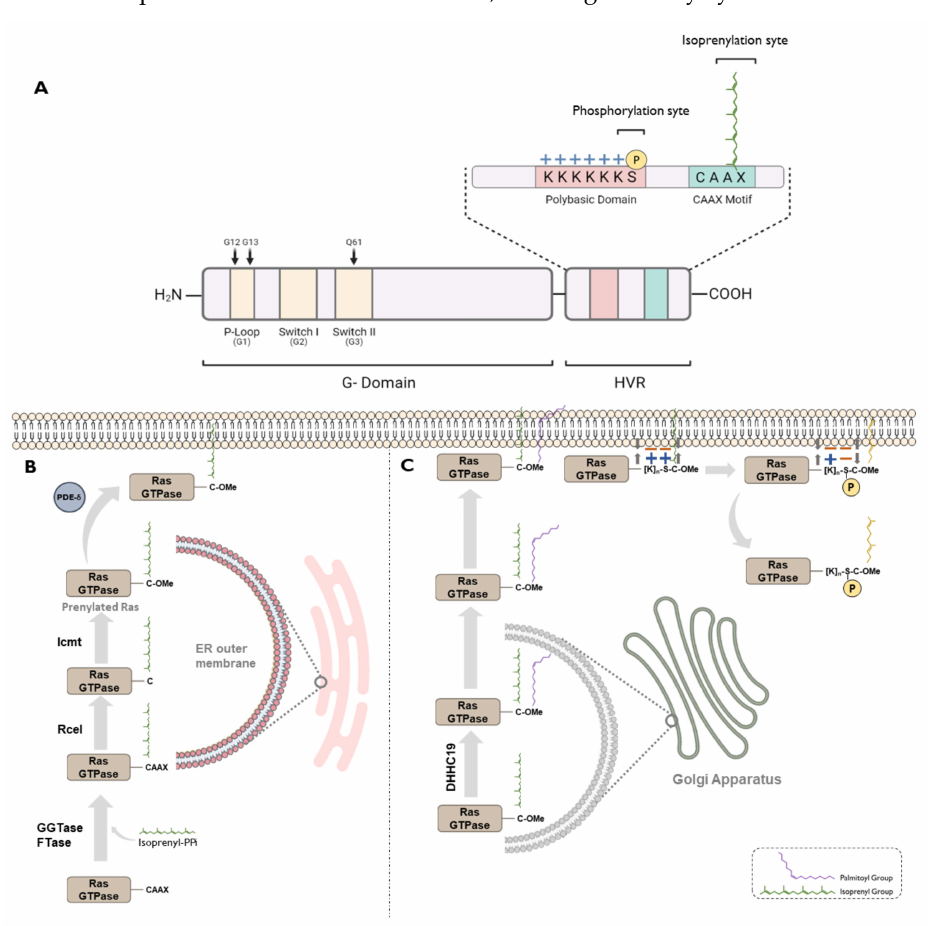
Figure 2. ( A ) General protein structure of Ras-GTPase members. ( B ) Regulation of Ras-GTPase membrane location by isoprenylation (farnesylation and geranylgeranylation). ( C ) Regulation of Ras-GTPase membrane location by palmitoylation and